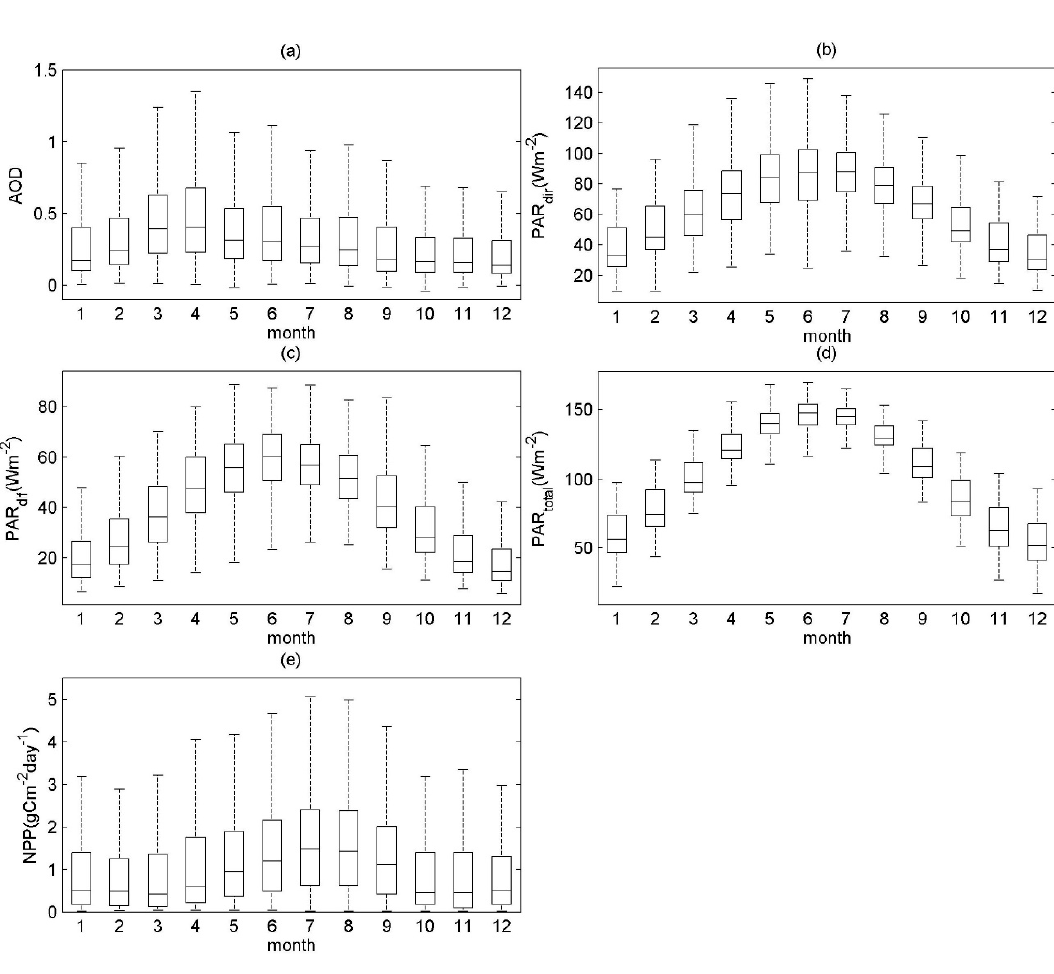
Figure 2. Boxplots of the average monthly AOD ( a ), PAR dir ( b ), PAR dif ( c ), PAR total ( d ) and NPP ( e ) from 2001 to 2017.